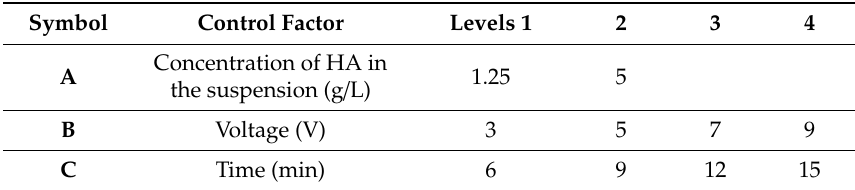
Table 1. Selected factors and